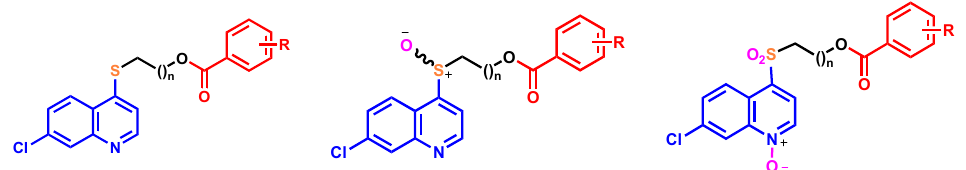
Figure 1. General structure of [(7-chloroquinolin-4-yl)sulfanyl, sulfinyl, and sulfonyl]alkyl benzo- ates.